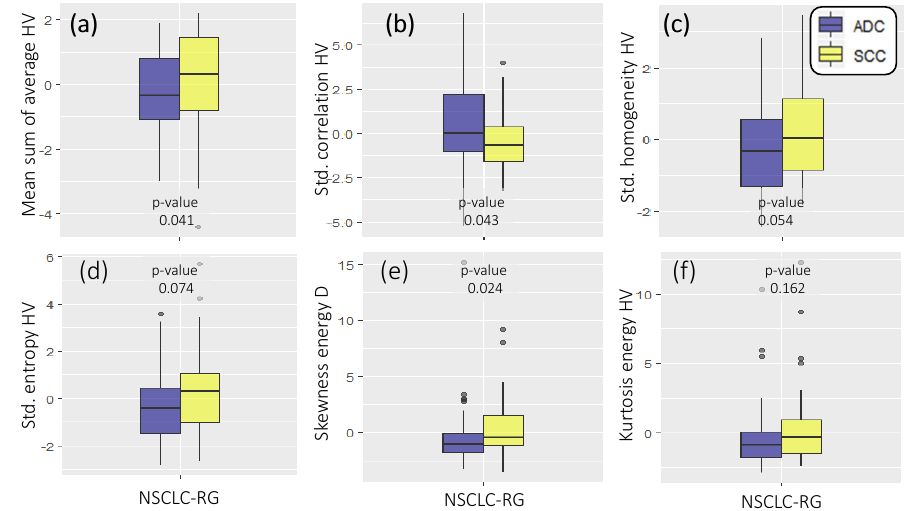
Figure 6. Box plots ( a – f ) of the top-ranked radiomics features together with their p -value from Wilcoxon ranksum testing (unadjusted), when comparing ADC (blue) to SCC (yellow) non-small cell lung cancer subtypes in the NSCLC-R